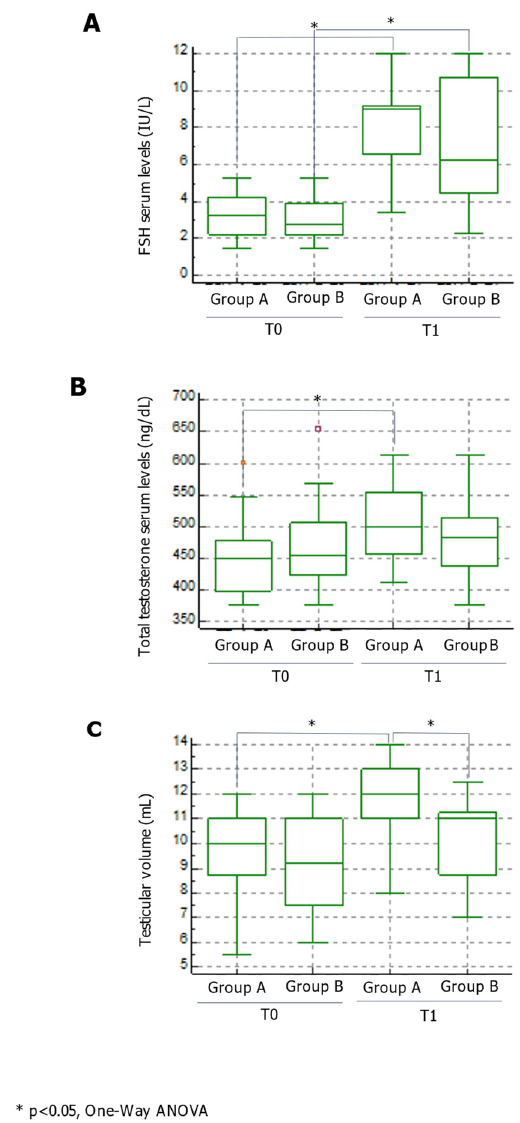
Figure 2. Effects of the two FSH therapeutic schemes on hormone serum levels and testicular volume. Data on FSH (panel A ) and TT (panel B ) serum levels, and on testicular volume (panel C ) are shown. FSH, follicle-stimulating hormone; TT, total testosterone. * p < 0.05.